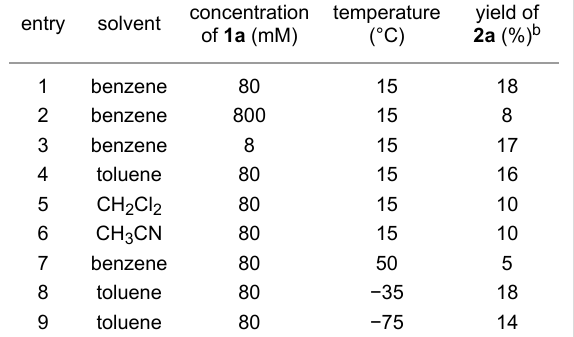
intramolecular Paternò–Büchi reaction of C is faster than the first intermolecular Paternò–Büchi reaction of 1a . The photore- action of 1b (R = Me) gave 2b and 3 in 25% and 18%, respec-